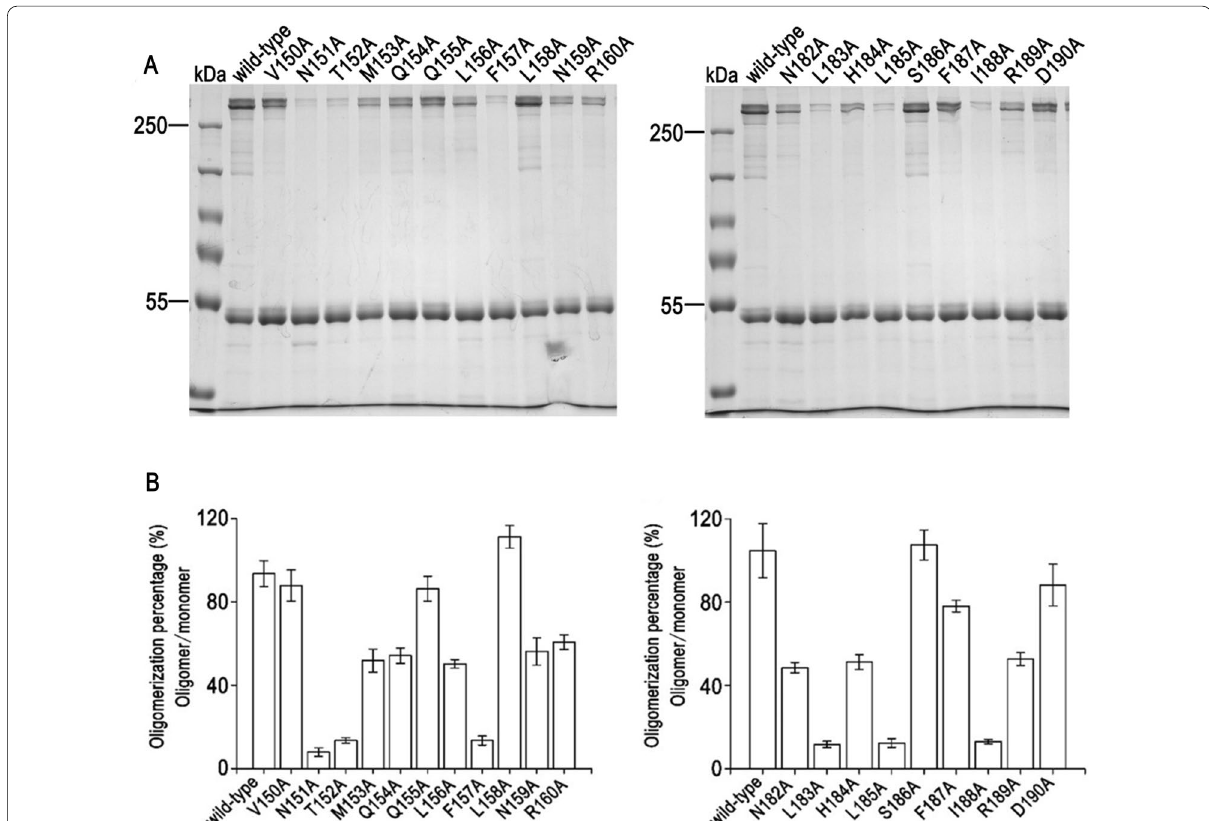
Fig. 3 Oligomerization assay of Cry2Ab mutants. A Assemble of Cry2Ab oligomers. B Oligomerization percentage of Cry2Ab was calculated by image J. The data were presented with the mean value standard deviations from triplicate biological experiments ±